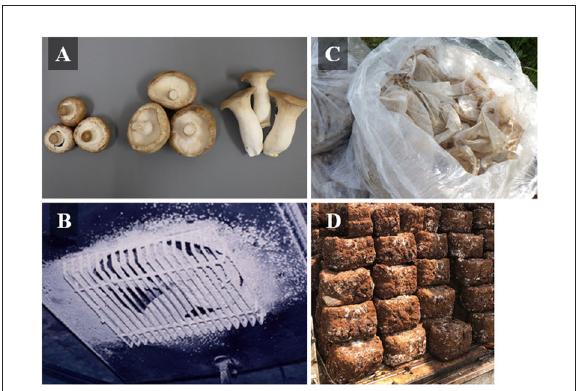
FIGURE2 “Dark” sides of mushroom production in sustainability. (A) An example of mushrooms commercially available in Japan (Tottori prefecture). Left, button mushrooms; middle, shiitake mushrooms; right, king trumpet mushrooms. Button mushrooms can be harvested before their pileuses (caps) expand, but shiitake and oyster mushrooms including king trumpet mushroom are morphologically difficult to harvest before their hymeniums (lamellas) that spores form are exposed. (B) A contaminated ventilation fan with spores derived from king trumpet mushroom. Photo by Yasushi Obatake. (C,D) Waste derived from bag cultivation. (C) Heat-resistant bags made of polypropylene or high-density polyethylene. Alternative bags composed of polylactic acid have been developed, but their use is not widespread due to their relatively high cost and limited biodegradability. (D) Spent mushroom substrate contains various materials depending on the region. It is expected that